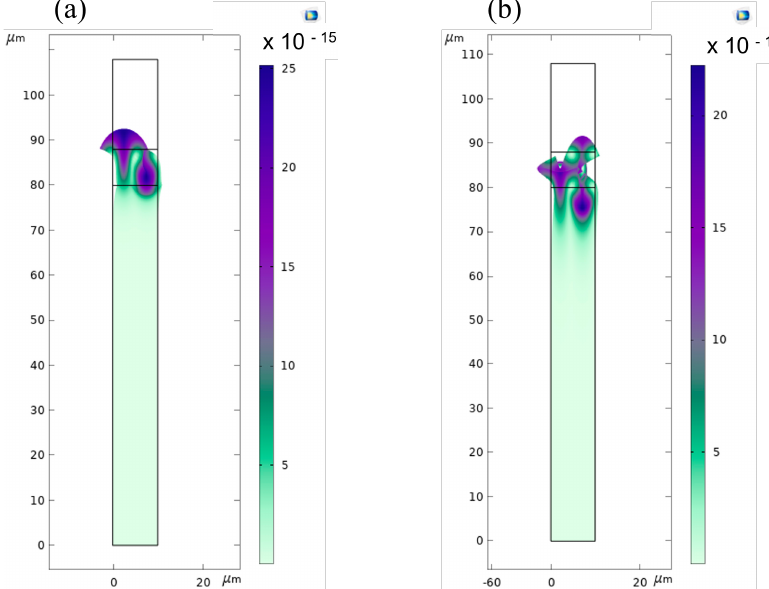
Figure 12. The parametric representation of the α / k vs. ∆ v under bottom illumination, ( b ) Sezawa wave under bottom illumination, ( c ) Rayleigh wave under top illumination, and ( d ) Sezawa wave under top illumination; σ is the variable parameter.